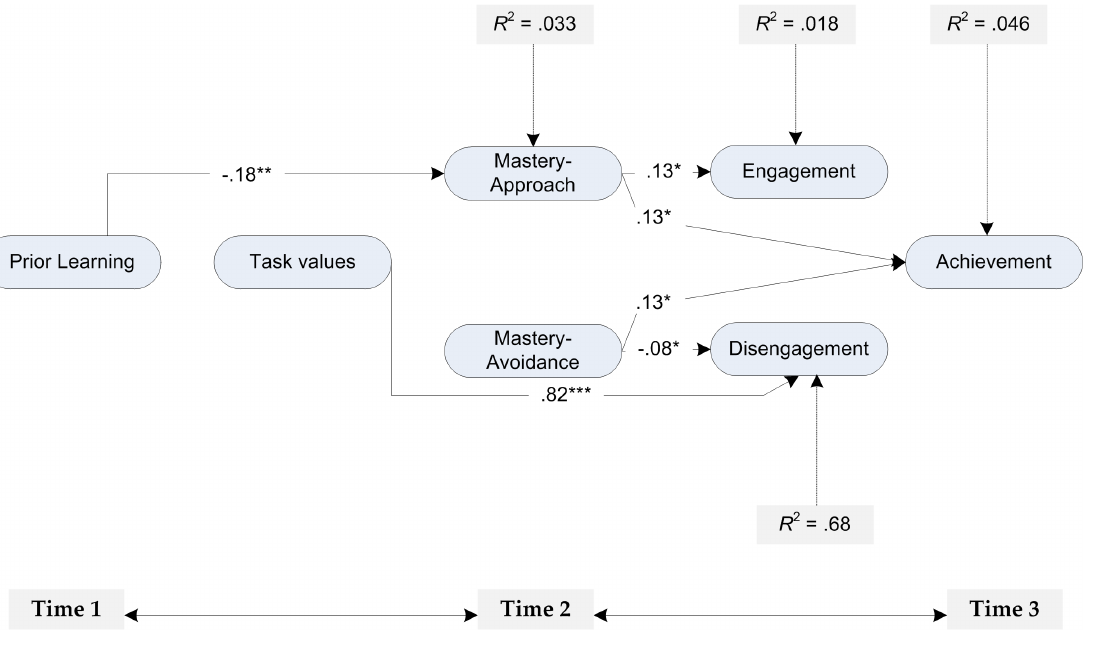
Figure 2. Final model of mastery goals, task value, and academic engagement-disengagement. Note. Paths are statistically significant at * p < .05. ** p < .01. and *** p < .001. For clarity, non-statistical significant paths have been omitted. Scores for disengagement have been reversed, so that a high score reflects more inclination towards engagement. Scores for academic disengagement (i.e., a participant less likely to disengage) have been reversed so that a positive relation for task value implies a student is more likely not to disengage. Likewise, a negative association between a mastery-avoidance goal orientation and academic disengagement implies an inverse